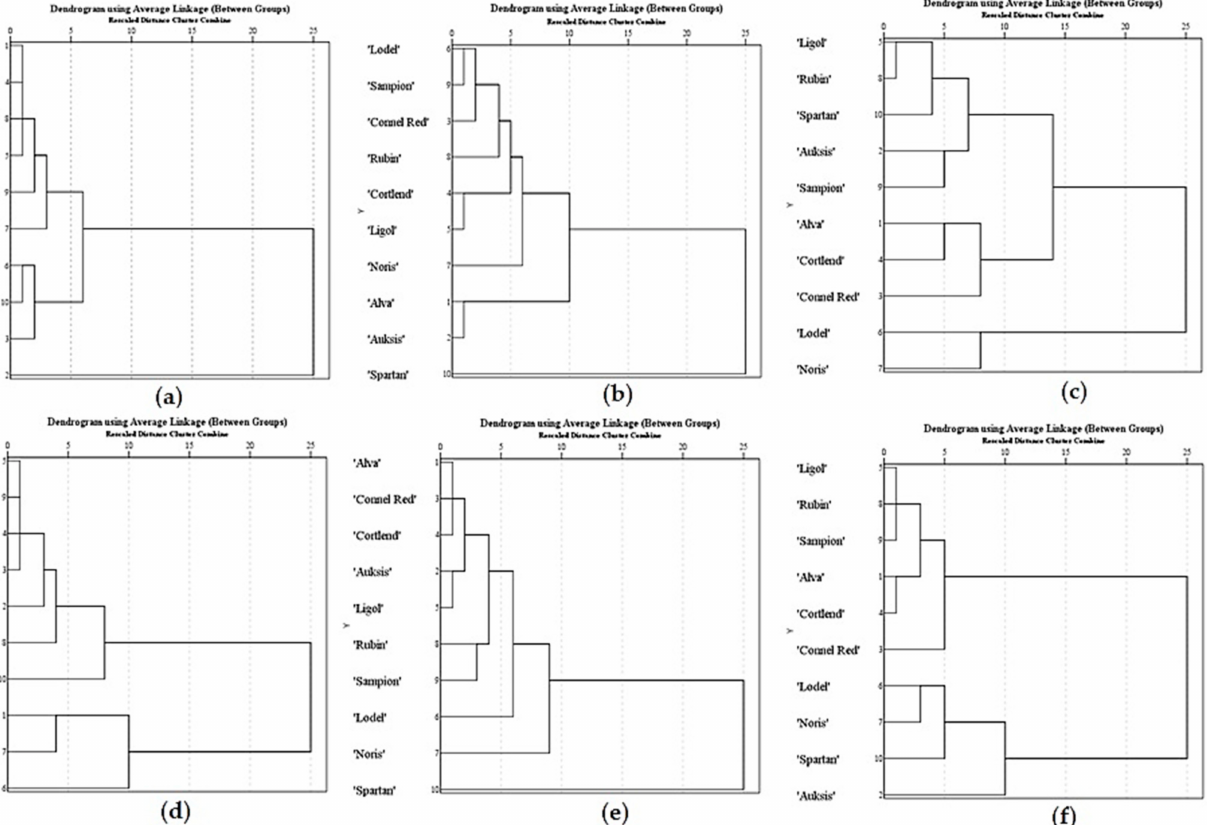
Figure 7. Hierarchical cluster analysis of the identified phenolic compounds in apple samples stored under controlled atmosphere: ( a ) Dendrogram of phenolic acid; ( b ) Dendrogram of flavonols; ( c ) Dendrogram of flavan-3-ols; ( d ) Dendrogram of dihydrochalcone; ( e ) Dendrogram of anthocyanins; ( f ) Dendrogram of the total amount of phenolic